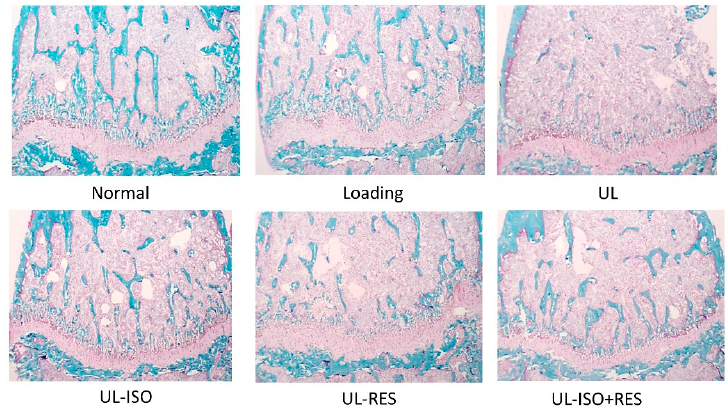
Figure 4. Bone histological stain analysis of distal femur in hindlimb-unloading mice. The right femurs were fixed, and embedded in glycolmethacrylate without decalcification. Then, serial sections were cut longitudinally, and sections were stained with Villanueva Goldner stain for discrimination between mineralized and unmineralized bone, and for the identification of cellular components. In Villanueva Goldner-stained sections, calcified bone is represented in green and osteoids are represented in red. Normal, normally housed group; Loading, loading group; UL, hindlimb-unloading mice fed a control diet; UL-ISO, hindlimb-unloading group fed a 0.16% soy-isoflavones conjugates diet; UL-RES, hindlimb-unloading group fed a 0.15% RES diet; UL-ISO + RES; hindlimb-unloading group fed a 0.16% soy-isoflavones conjugates and resveratrol